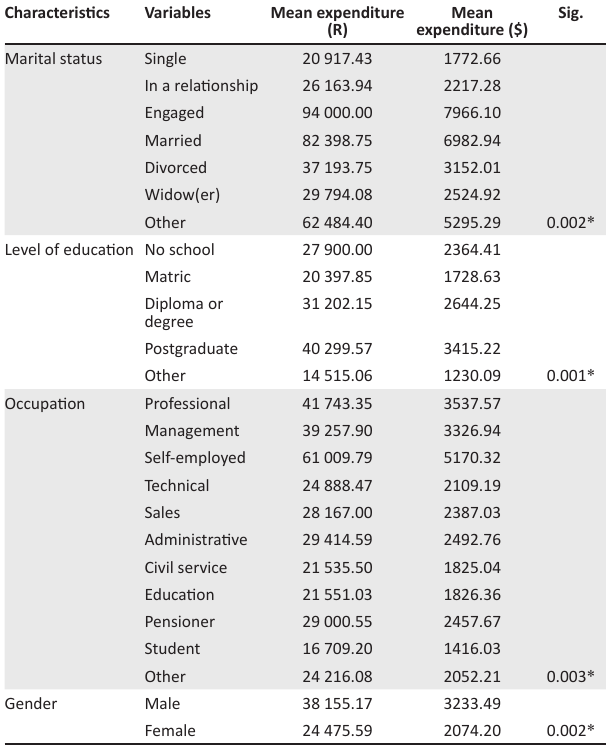
TABLE 3: Mean expenditure – Socio-demographic factors.